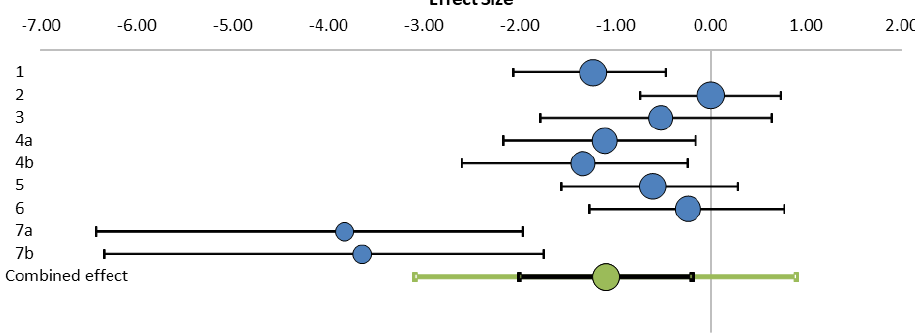
Figure 2. Forest plot of mite density in colonies (screen bottom board vs. wooden floor) from seven studies.